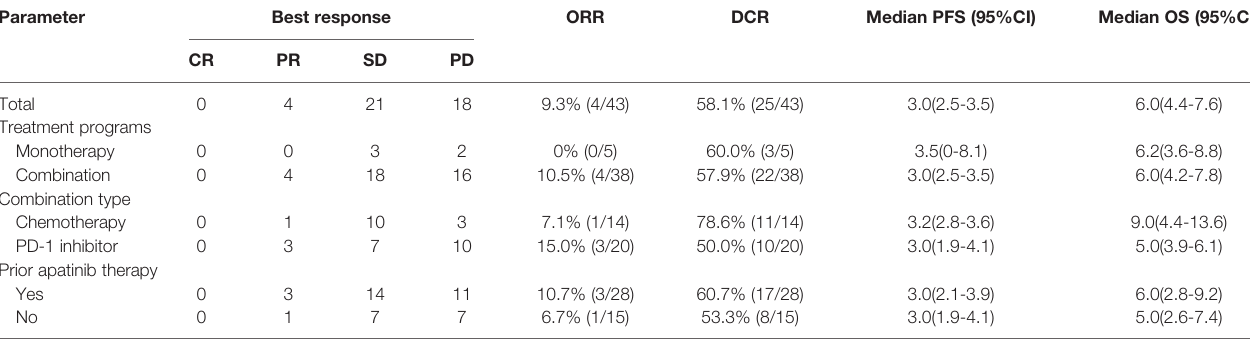
TABLE 2 | Ef fi cacy of anlotinib in patients with advanced or metastatic gastric cancer. Parameter